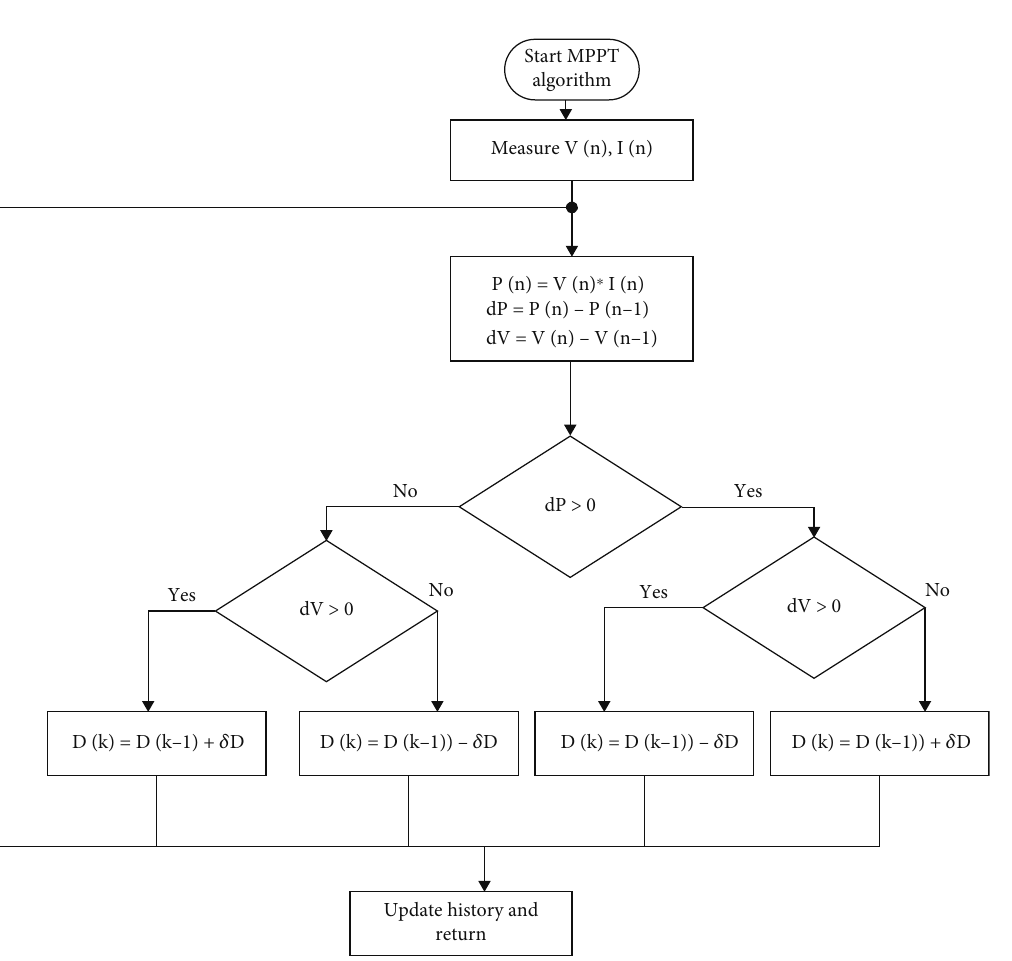
Figure 1: Flowchart of the perturb and observe algorithm [22,